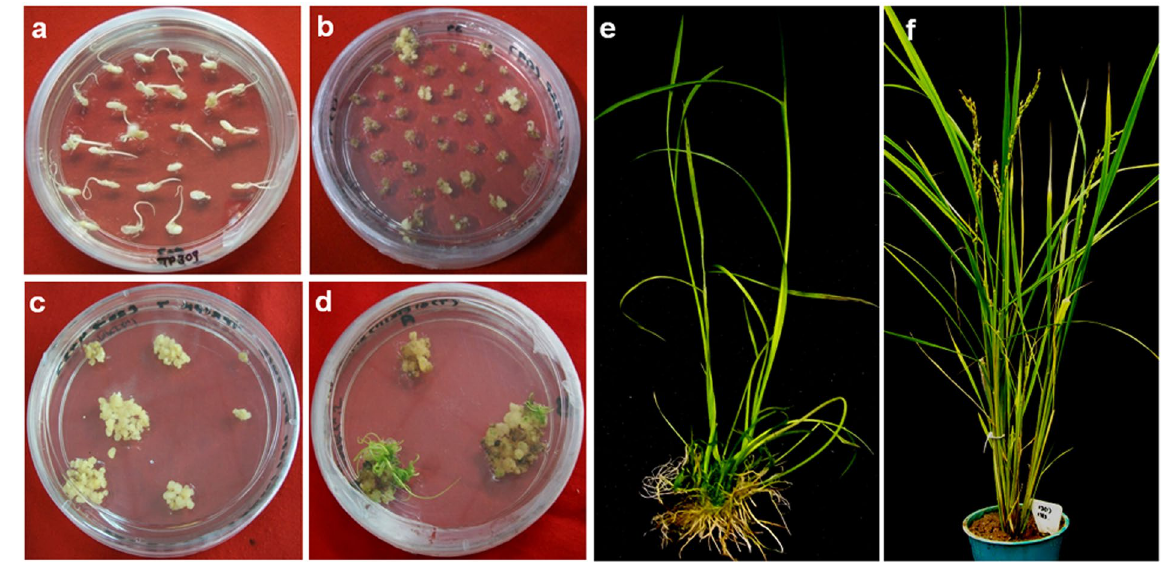
Figure 2. In vitro regeneration and stable genetic transformation of TP-309 rice plants. ( a ) Seeds grown on callus induction medium; ( b , c ) Transformed calli growing on selection medium; ( d ) Regenerating callus on selection medium; ( e ) Rooted putative transformants; ( f ) Putative transformant at panicle formation stage.